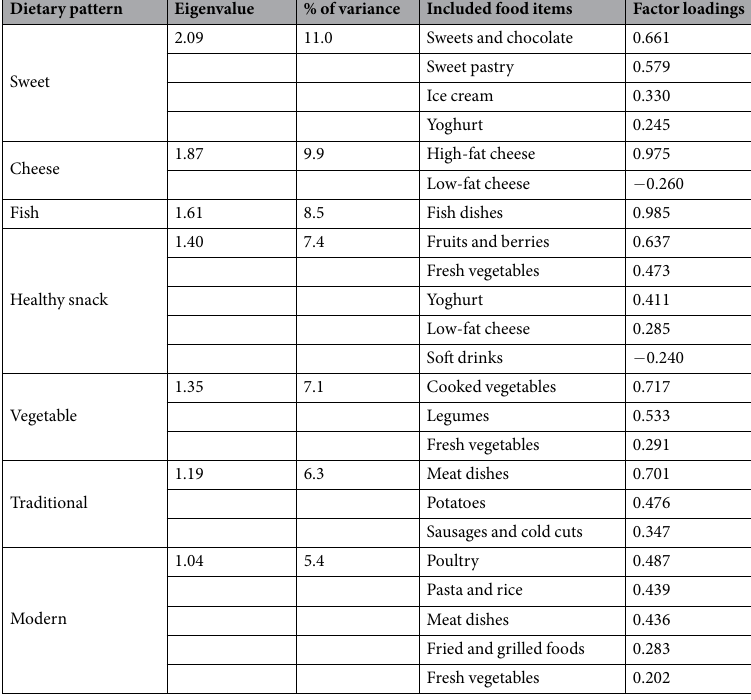
Table 2. Factor analysis-derived dietary patterns (n = 668). Eigenvalues are the variances of the factors; % of variance shows the per cent of total variance accounted by each factor; the factor loadings represent the correlation of each food item with the given dietary pattern. Factors are formed from the food frequency questionnaire